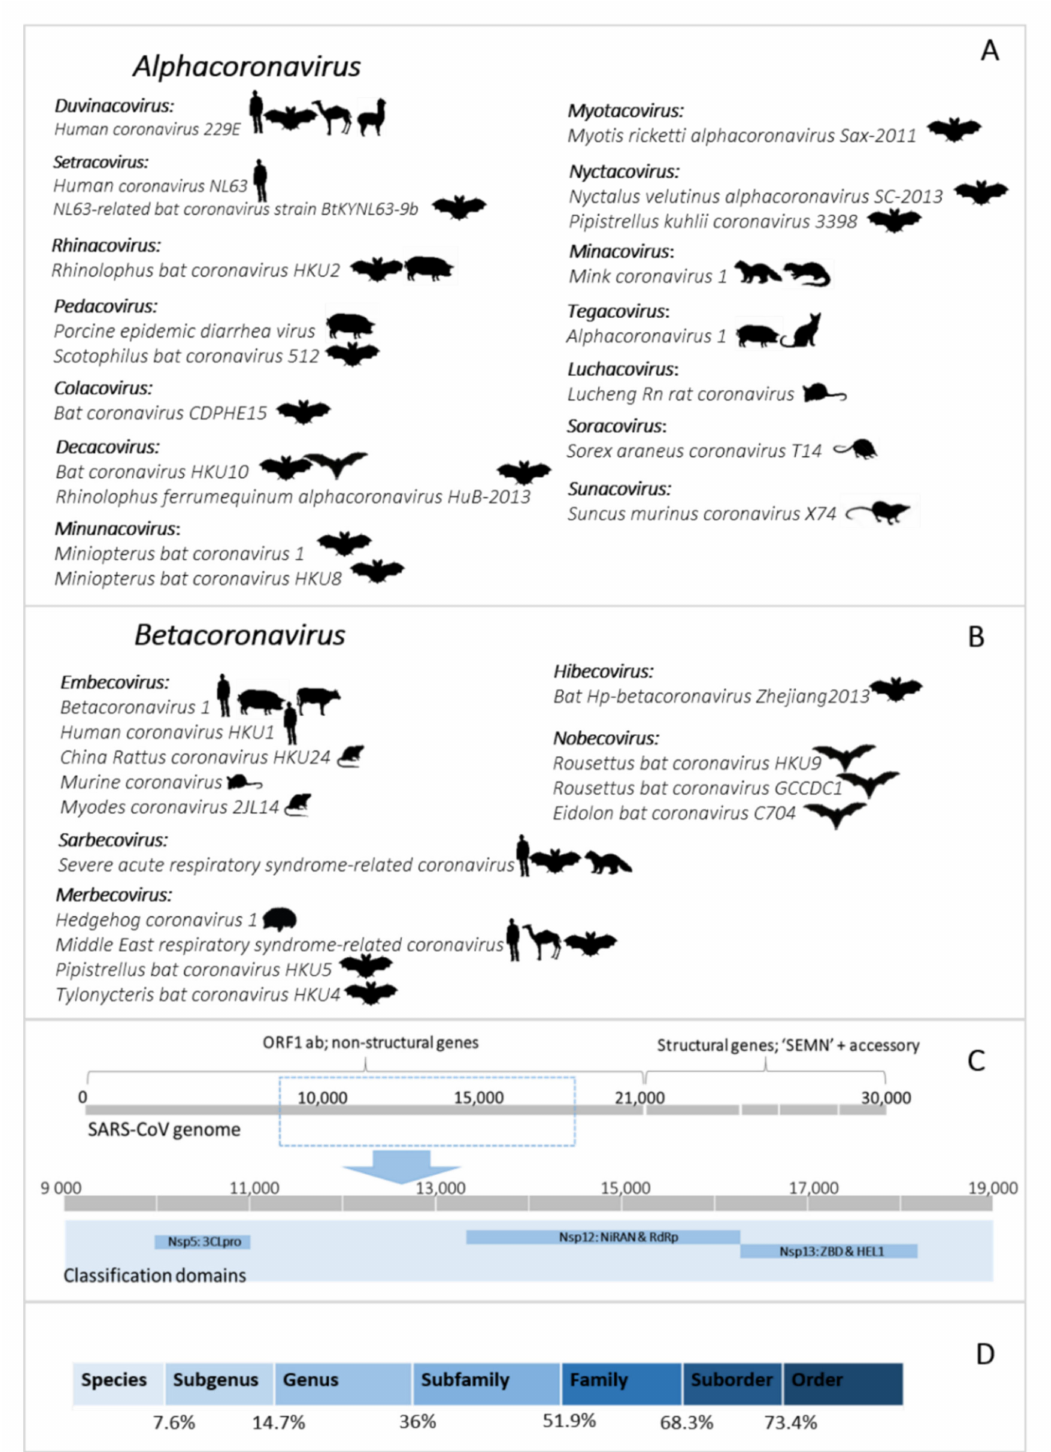
Figure 1. ( A , B ) Current coronavirus subgenera (bold) and species of the Alphacoronavirus and Betacoronavirus genera. The images indicate host species associated with the virus species. Figure constructed with the species listed on the 2019 Release of the ICTV Virus Taxonomy 9th Report MSL#35: (Available at https://talk.ictvonline.org/ictv-reports/ictv_9th_report/ positive-sense-rna-viruses-2011/w/posrna_viruses/222/coronaviridae accessed on 12 December 2020). ( C ) Representation of the coronavirus genome (based on the reference genome NC_004718.3 SARS coronavirus Tor2) depicting the locations of important domains for classification of species (NSP5 (3CLpro), NSP12 (NiRAN and RdRp), and NSP13 (ZBD and HEL1)). ( D ) Thresholds of the taxonomic demarcation criteria [24]. Novel viruses are part of a taxonomic level if the divergence within the five concatenated replicase domains is less than the indicated amino acid